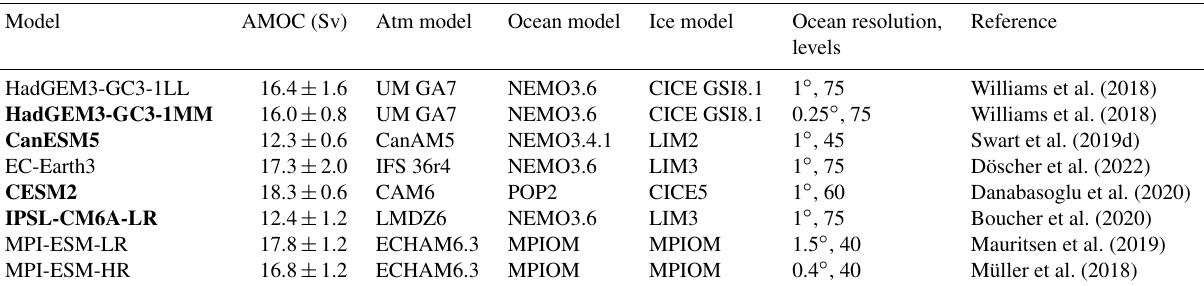
Table 2. Models used in this study. First column lists the models. Second column shows the AMOC strength in the historical experiments over the years 2005–2014, with the mean and twice the standard deviation of the ensemble values. Subsequent columns list the component atmosphere, ocean and sea ice models, the nominal ocean resolution number of vertical levels, and references. Those models which have demonstrated an AMOC hysteresis in this study are in bold.